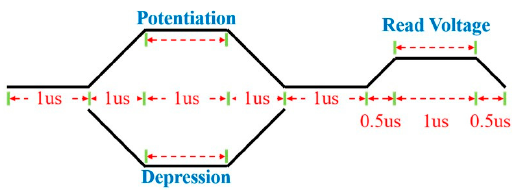
Figure 7. Pulse waveforms of the potentiation and depression process.